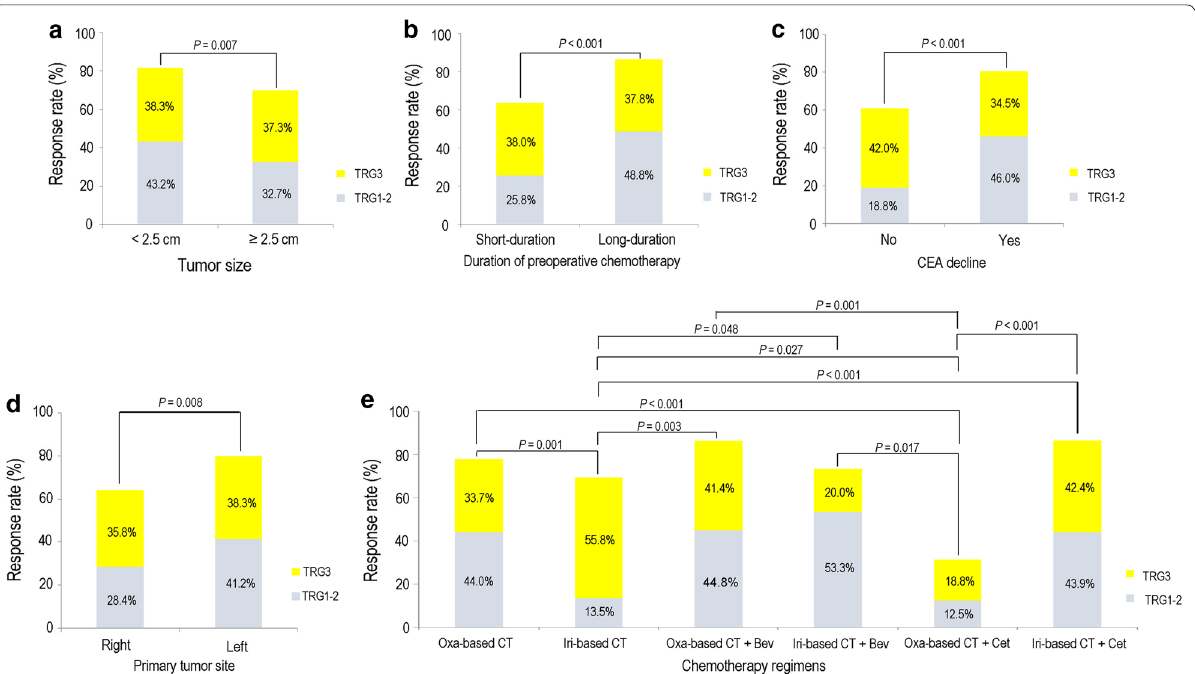
Fig. 3 Pathologic response of colorectal cancer patients with liver metastasis according to potential factors. Metastases were classified according to tumor size ( a ), duration of preoperative chemotherapy ( b ), CEA variation ( c ), primary tumor site ( d ), and preoperative treatment ( e ). The